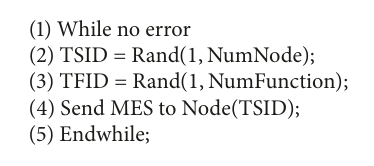
Algorithm 1: Sink node randomly generated